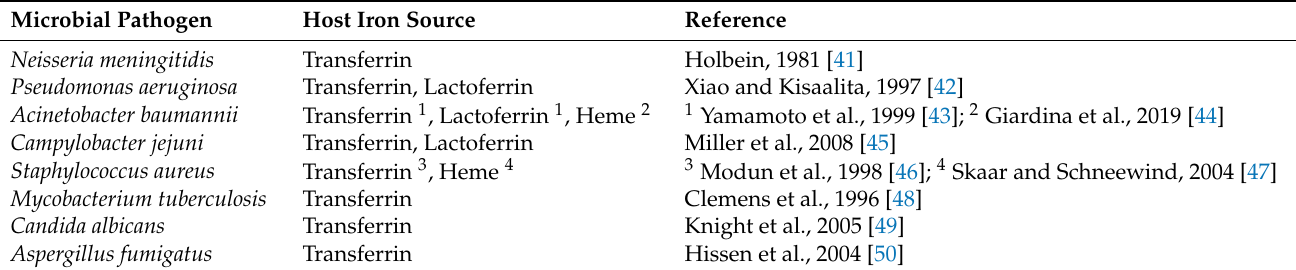
Table 3. Iron sources for pathogenic